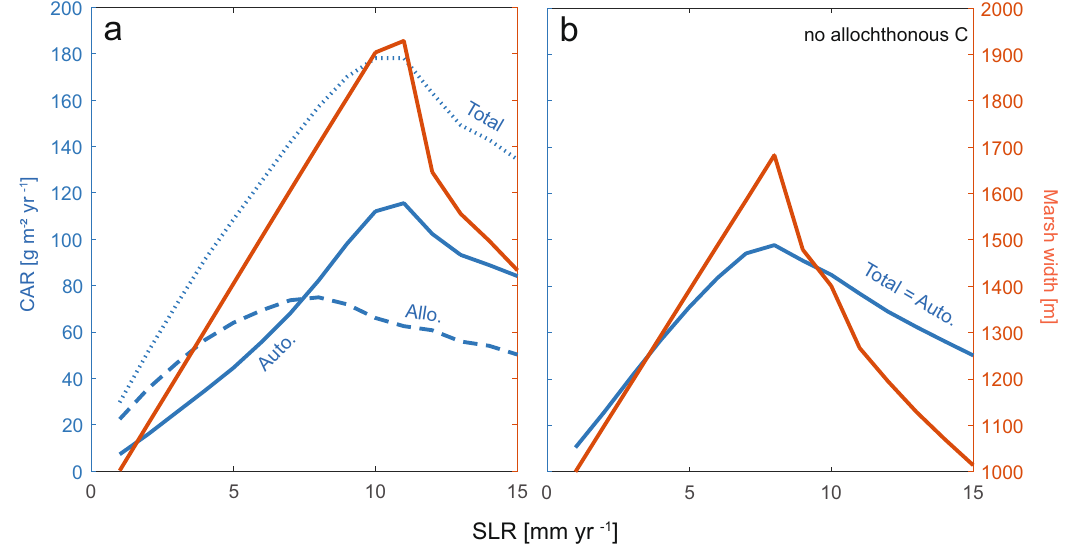
Fig.3|Carbonaccumulationandmarshwidthpeakatintermediateratesofsea level rise (SLR). a Carbon accumulation rate (CAR, blue lines, averaged over past 100yearsovermarshplatform)andmarshwidthattheendofthemodelsimulation (red line). Dashed blue line indicates allochthonous (allo.) carbon, solid blue line indicates autochthonous (auto.) carbon, and dotted blue line indicates total